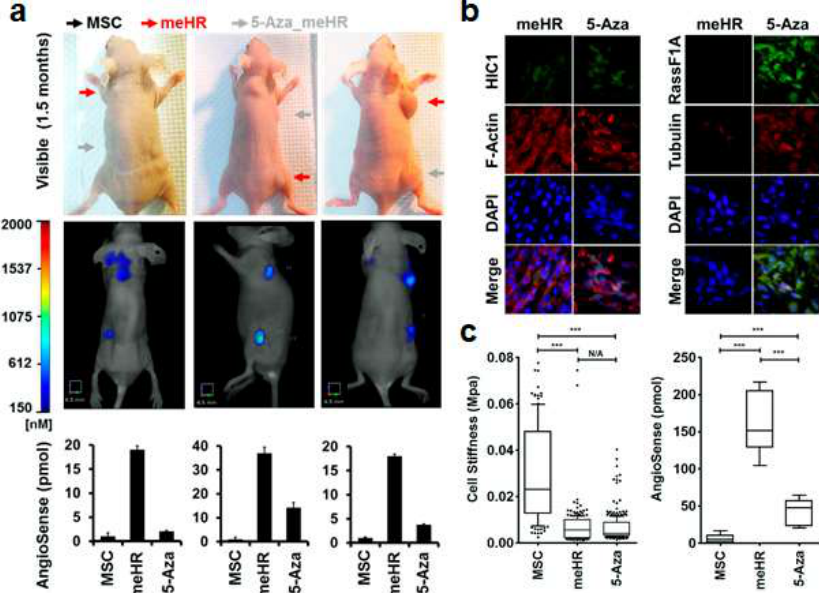
Figure 4. Targeted HIC1 and RassF1A methylation-induced loss of tubulin expression in vivo. Mesenchymal stem cells (MSCs), me_HR-transformed MSCs, and 5-aza-2′-deoxycytidine (5-Aza)-treated me_HR-transformed MSCs were inoculated into nude mice to observe their tumoral development in vivo. ( a ) Inoculated me_HR cell tumors were reversed by 5-Aza treatment before inoculation. Arrows indicate the subcutaneous inoculation sites. The tumor mass was tracked using the florescent dye AngioSense, attached to the tumor. It allowed emitted light to be visualized and quantified using a fluorescence tomography, FMT 4000 machine (in vivo imaging system, Perkin Elmer, Billerica, MA, USA). Inoculation with me_HR-transformed MSCs (red arrows) led to large tumor masses, whereas that with 5-Aza-treated me_HR-transformed MSCs did not (gray arrows). Inoculated MSCs (black arrows) did not grow into tumor masses or exhibit background readings because the dye was injected through the tail vein. ( b ) Reduced tubulin expression in me_HR-induced tumors in vivo. Tumors from mice in ( a ) were surgically removed, cryosectioned, and immunostained using the indicated antibodies. HIC1, RassF1A, and tubulin expression were reduced in me_HR-transformed MSC-inoculated tumors but upregulated in smaller tumors from 5-Aza-treated me_HR-transformed MSC-inoculated mice (with 200 × magnification). ( c ) Correlation between the loss of stiffness and increased tumoral growth in vivo. The loss of stiffness (left) and increased tumoral growth (right) in me_HR-transformed MSC-induced tumors are plotted side by side for comparison (*** p < 0.001).